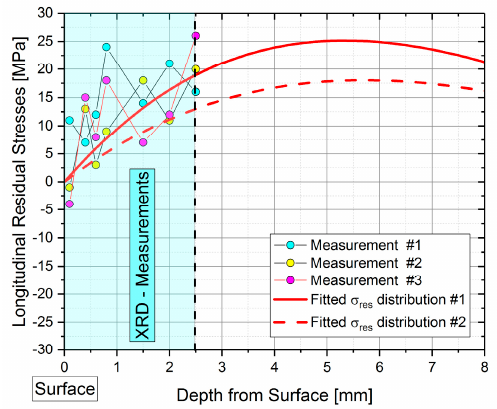
Figure 13. Illustration of measured and fitted residual stress distributions for assessments.